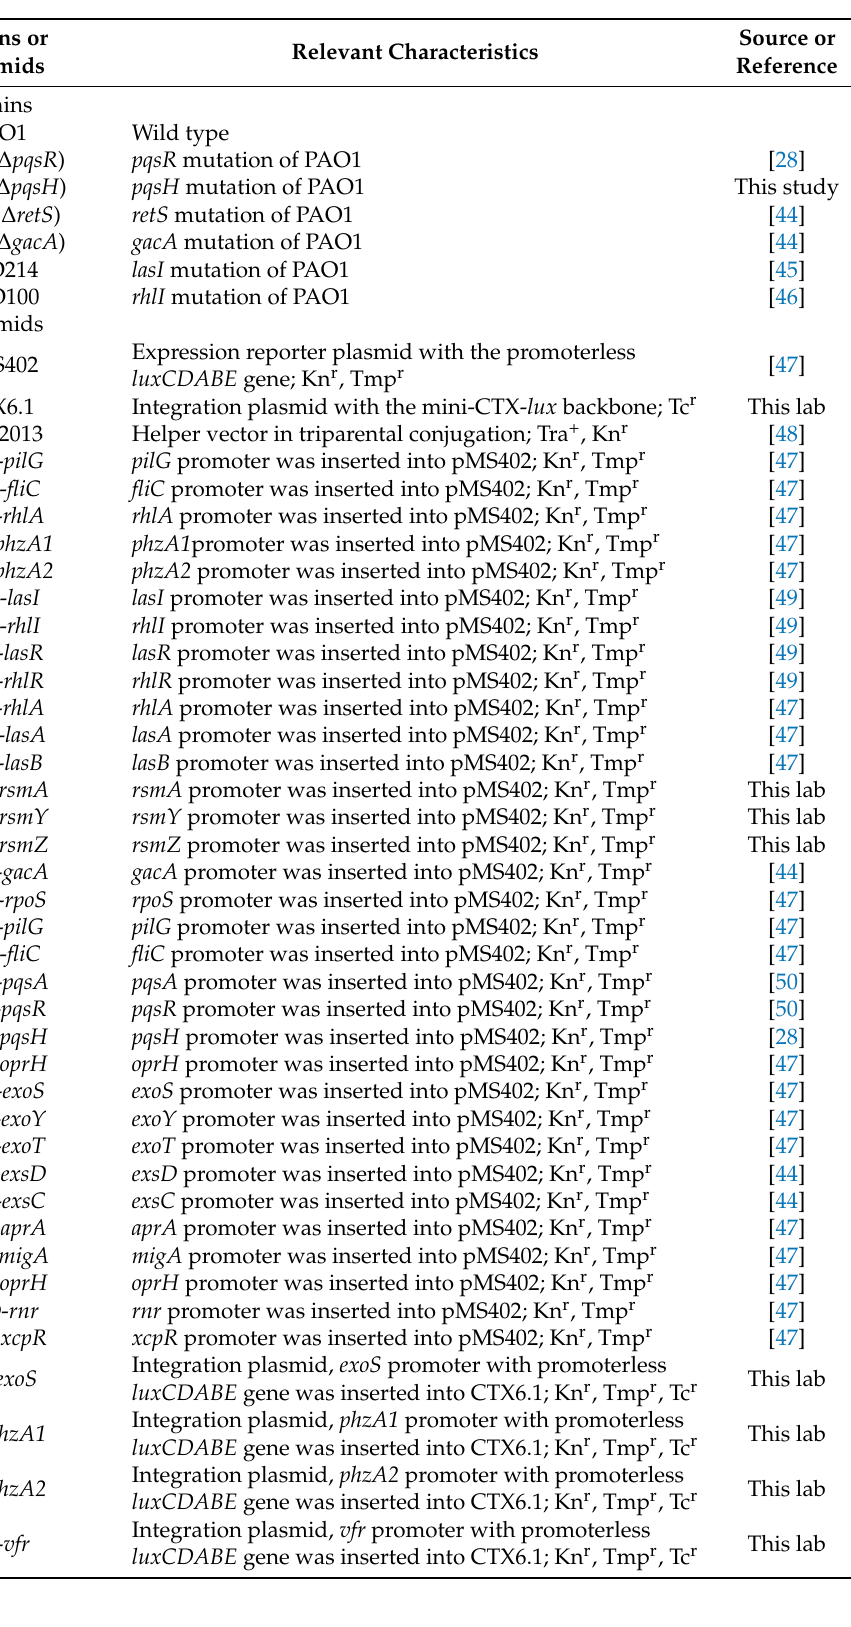
Table 3. Bacterial strains and plasmids used in this